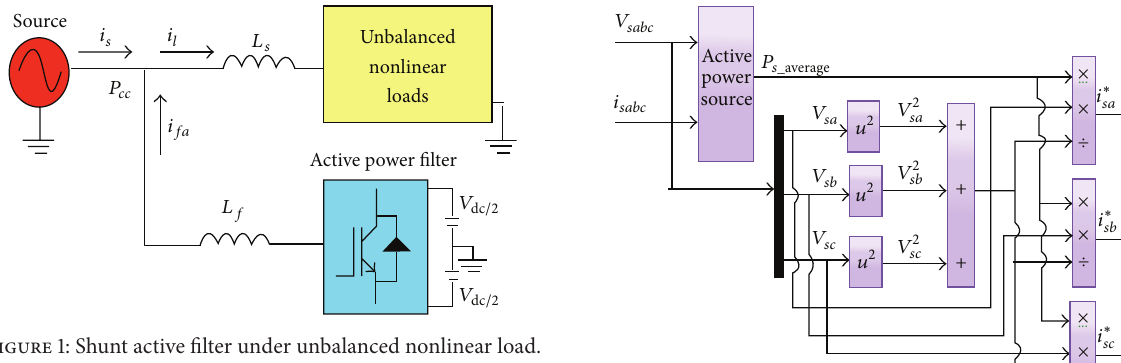
Hysteresis controllers are employed to generate switching signals of the voltage source inverter. The proposed active filter can compensate both harmonic currents and reactive power (correcting power factor to the unity) simultaneously.